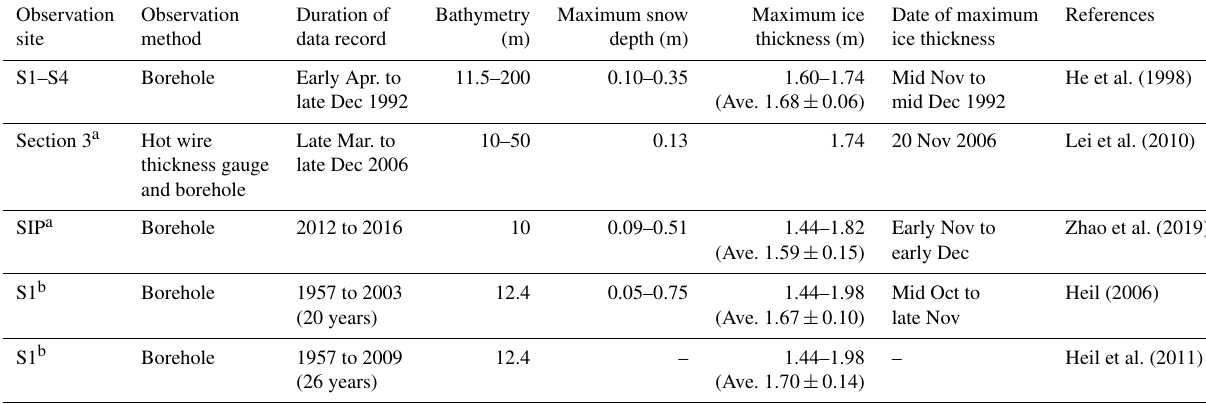
Table 3. Summaries of previous studies on the landfast ice (LFI) mass balance around ZS and DS.